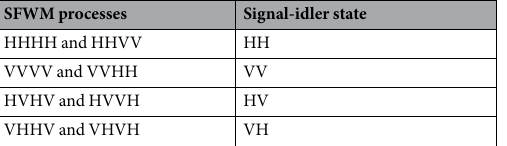
Table 1. A list of contributing SFWM processes (left column) to corresponding signal-idler polarization states (right column). The first, second, third, and forth letters specify polarization states of the signal, idler, first pump, and second pump